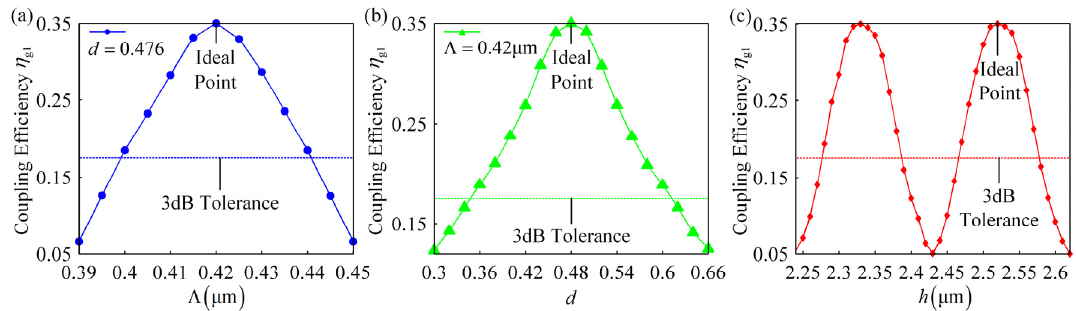
η Λ on the coupling efficiency g1 when duty cycle d is η Λ when grating period is η .